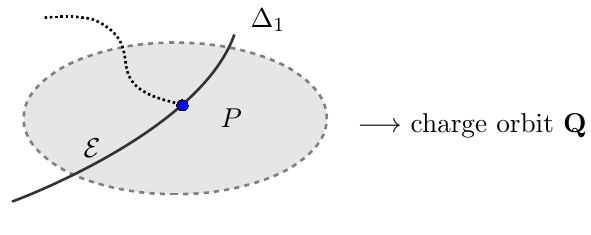
Figure 9 . Associating a charge orbit to a point P 2 (cid:1) 1 in local patch E in moduli space. In this single parameter degeneration no intersection locus of (cid:1) 1 within (cid:1) is in E